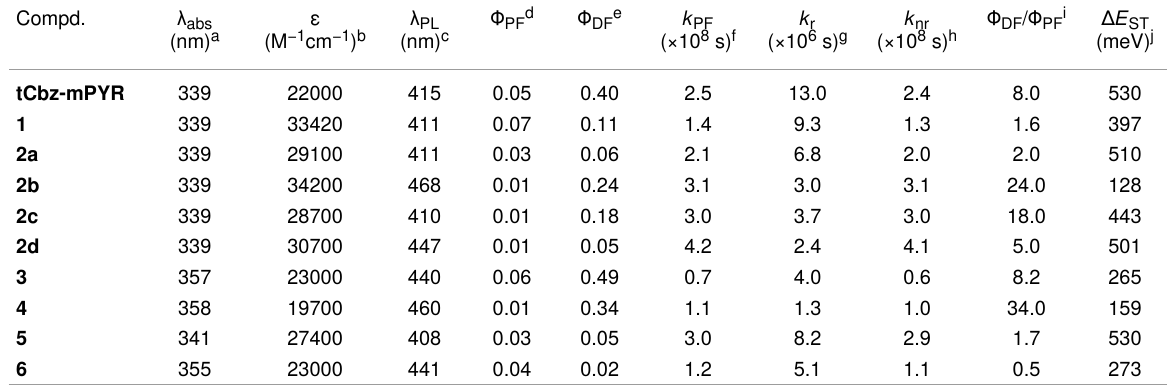
Table 2: Fluorescence parameters of carbazole–pyrimidine TADF compounds. Compd.